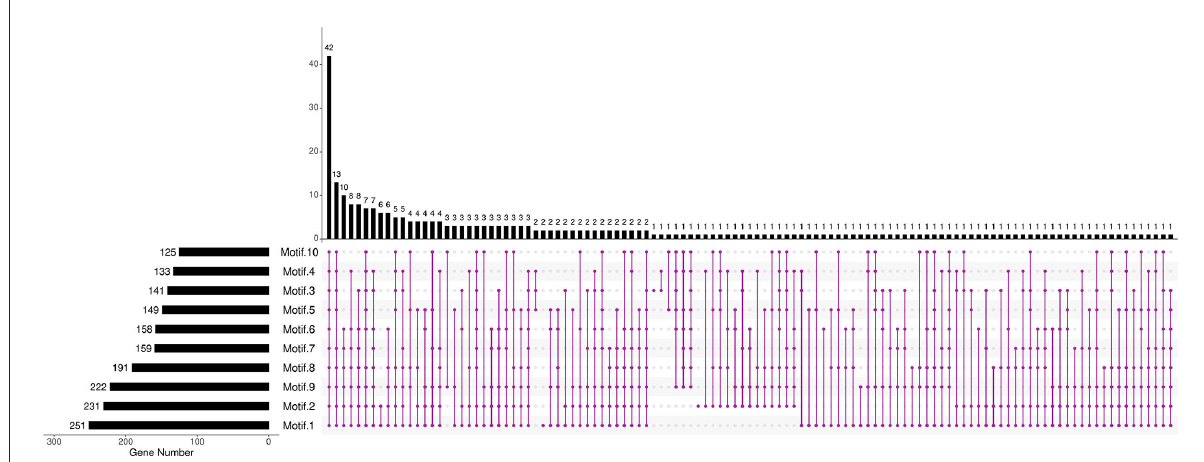
FIGURE1 Distributions of motifs in Bn RLPs. The Upset plot shows the distribution of motifs in the Bn RLPs. The number chart above represents the number of genes contained in each type of RLP. The bar chart at the bottom left represents the number of events included in each type of motif. The dotted line shows the types of motifs contained in the